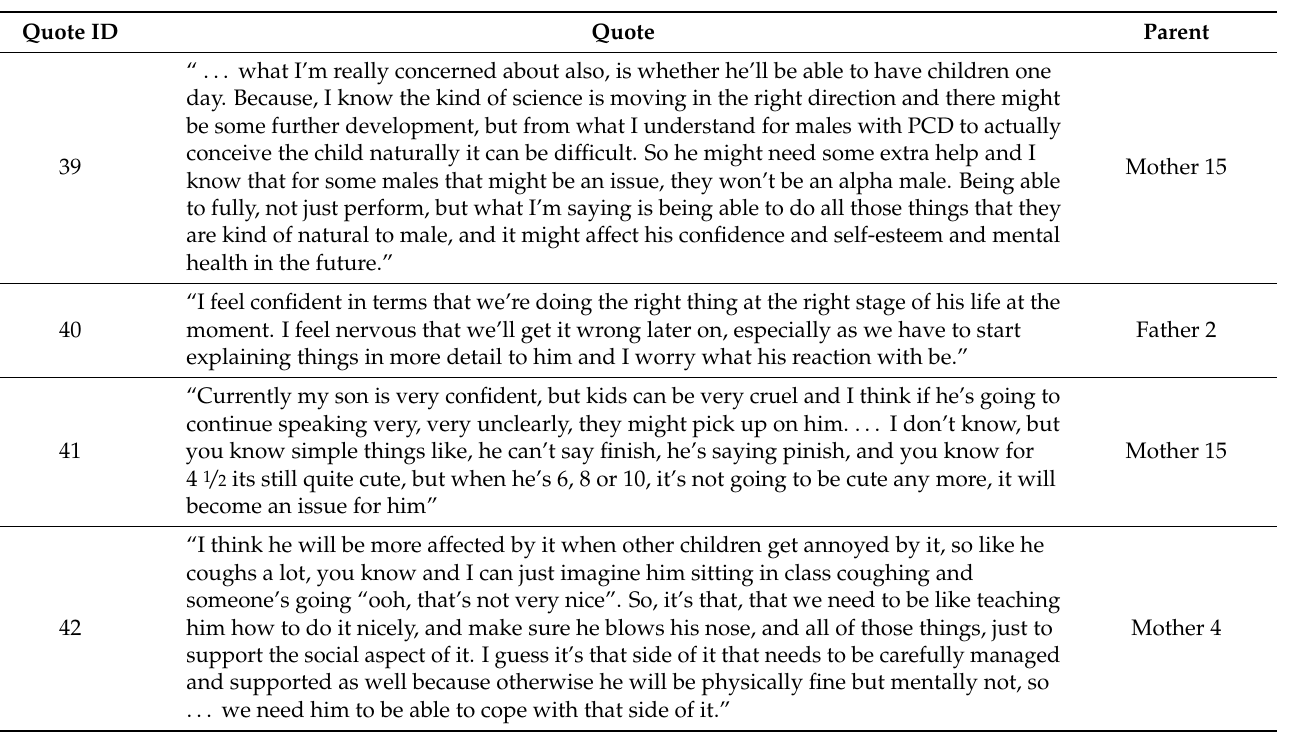
Table 7. Quotes from parents relating to concerns for the